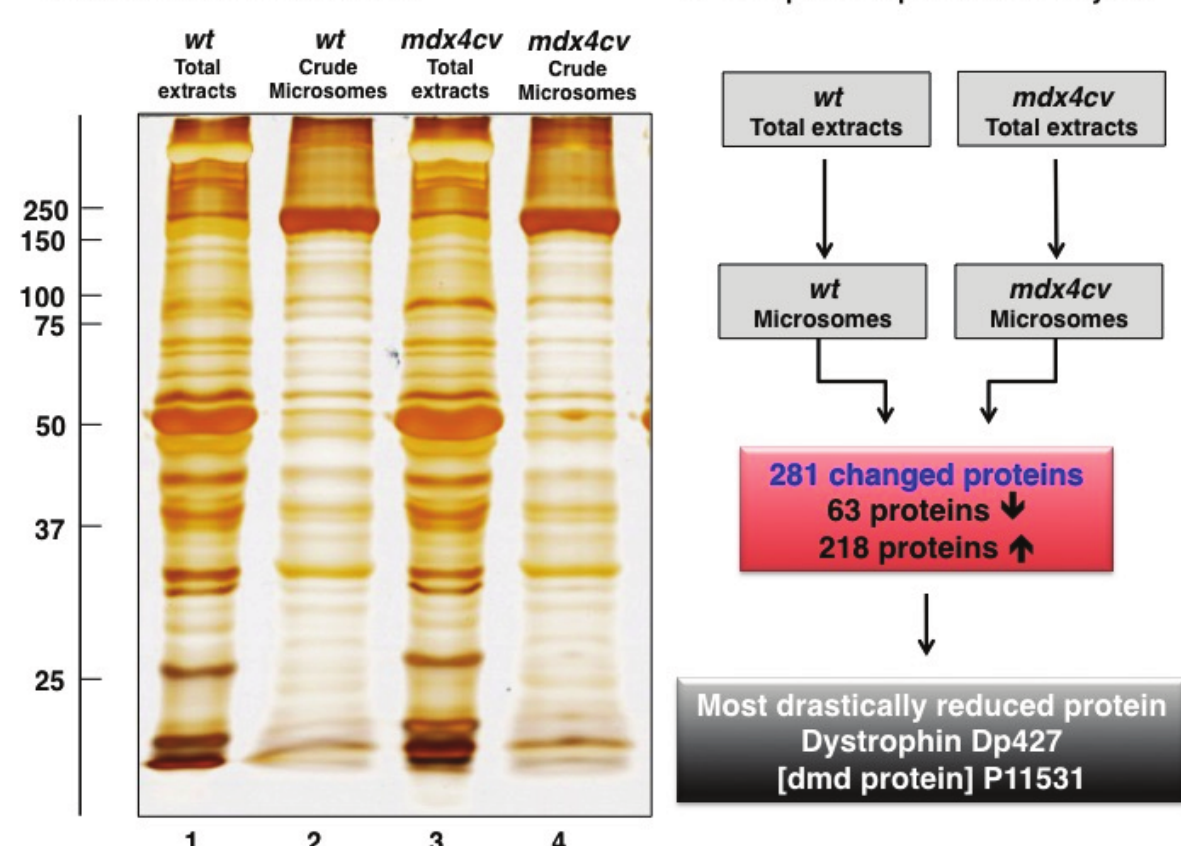
Figure 3. ( a ) Gel electrophoretic analysis of total muscle extracts (lanes 1 and 3) and the crude microsomal muscle fraction (lanes 2 and 4) from wild type ( wt ; lanes 1 and 2) versus dystrophic mdx-4cv (lanes 3 and 4) mice. Molecular mass standards (in kDa) are marked to the left of the panel. ( b ) Overview of the findings from the comparative proteomic analysis of the microsomal fraction from dystrophic versus wild type